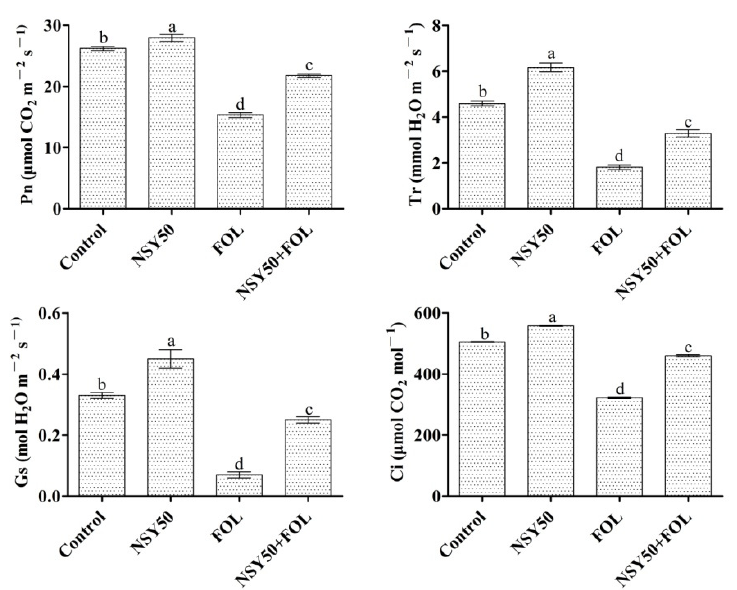
Figure 2. Photosynthetic parameters of tomato plants under different treatments. Different letters (a, b, c, and d) indicate statistically significant differences at p = 0.05 level.